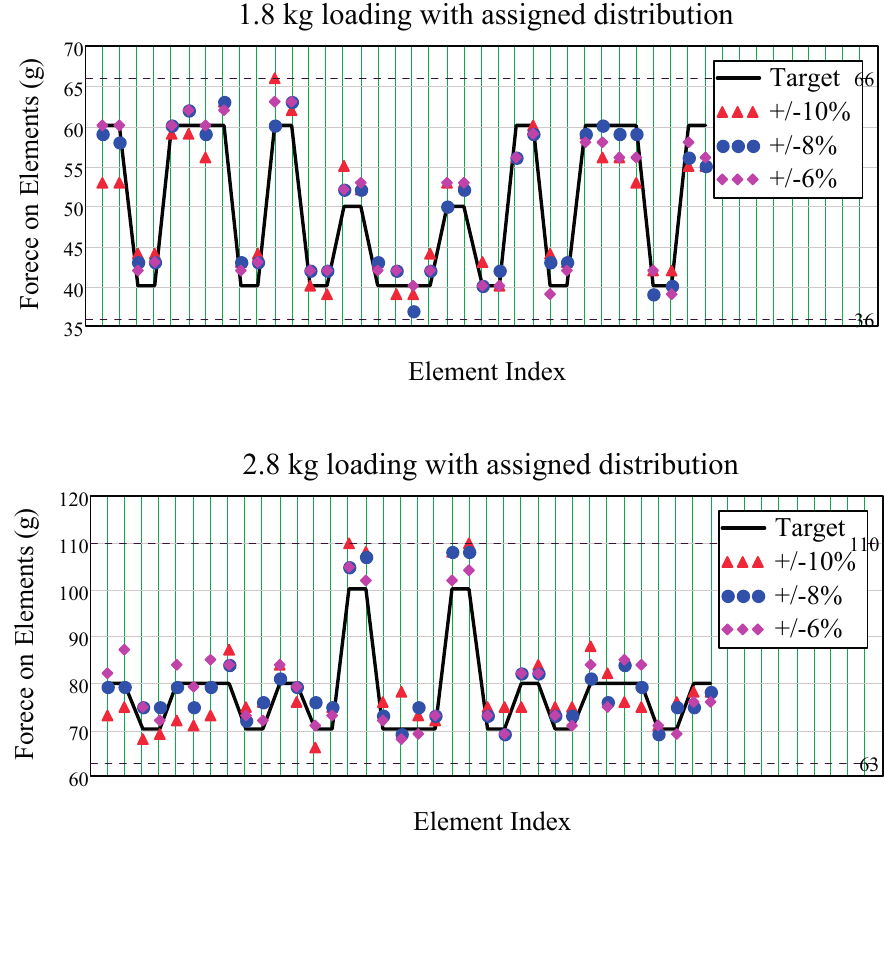
Figure 11. Results of automatic force distribution test with arbitral set distribution (the dash-lines indicate the upper and lower tolerance